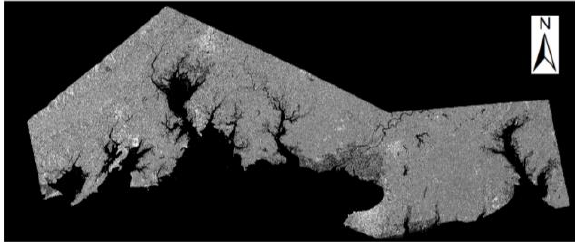
Figure 2. Sentinel-1A SAR intensity map of the study area.